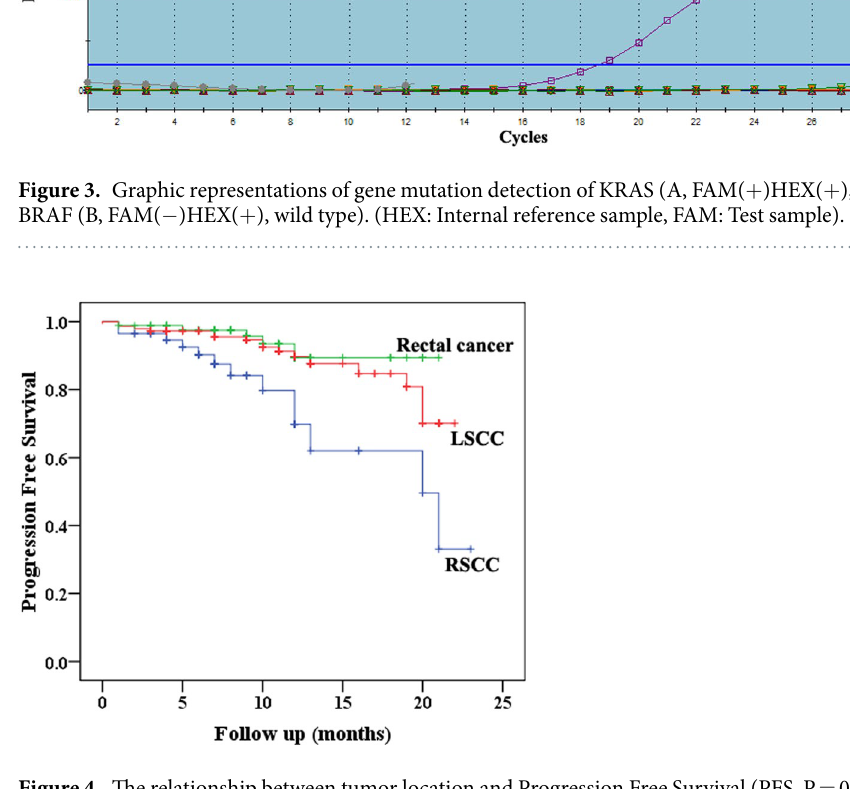
Figure 4. The relationship between tumor location and Progression Free Survival (PFS, P = 0.002) in 289 cases of Stage I~IV colorectal cancer patients (RSCC: Right-Sided Colon Cancer; LSCC: Left-Sided Colon